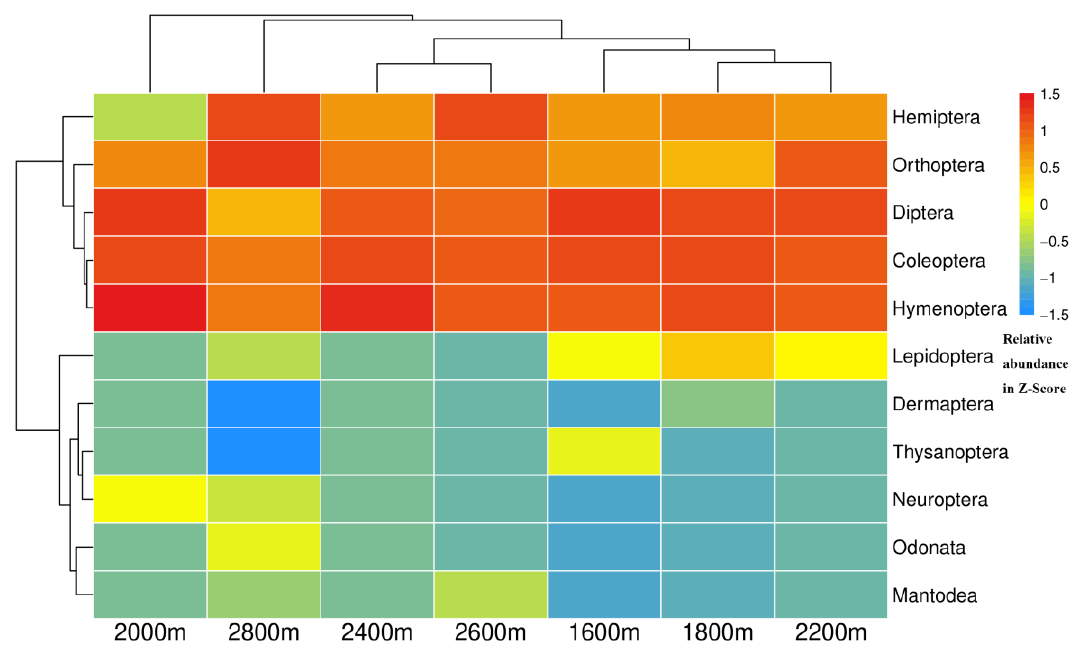
Figure 5. Heatmap of the insect taxa order along the altitudinal gradient in the Guandi Mountain. Table 3. The Hill numbers of insect species composition and diversity in typical vegetation community ecosystems along altitudinal gradient of the Guandi Mountain.